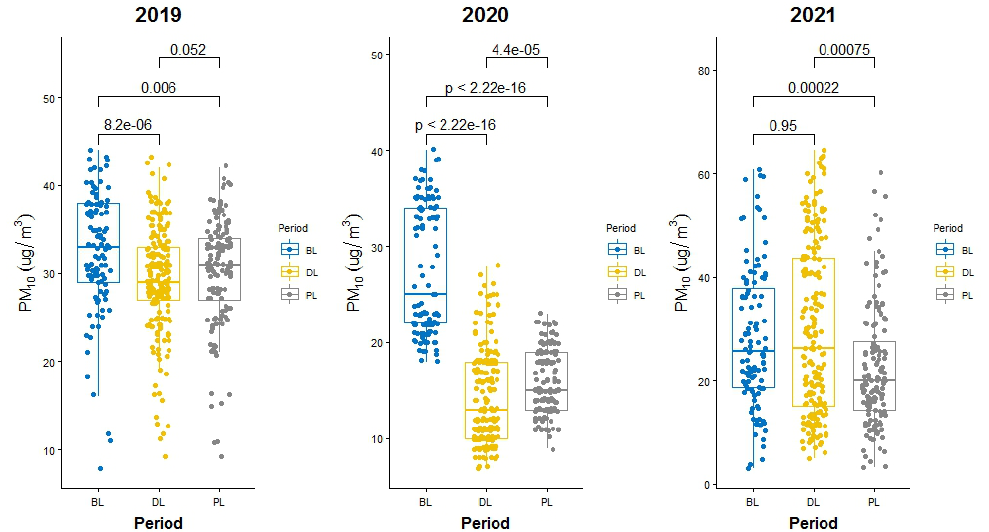
Figure 4. Contrast of PM 10 concentration by period (BL, DL, and PL) and year, using the Wilcox